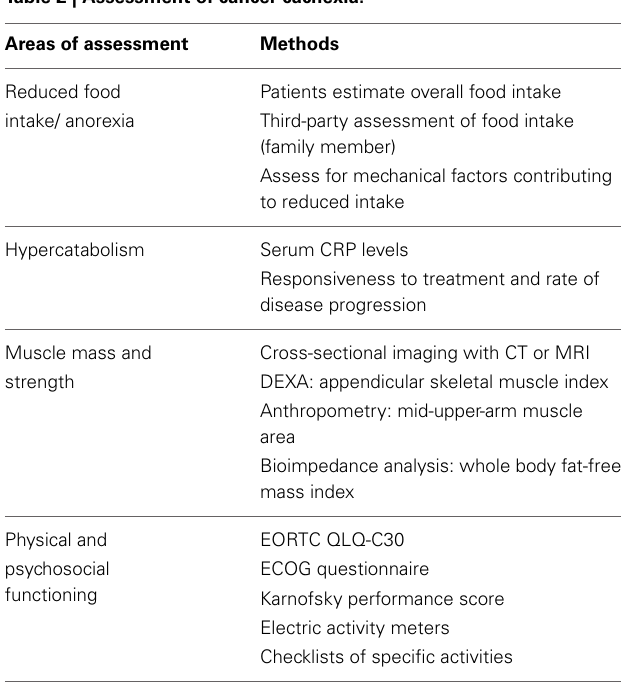
Table 1 | Diagnosis of cancer cachexia (Fearon et al., 2011). Weight loss greater than 5% over the past 6 months; or Weight loss greater than 2% in individuals with BMI less than 20kg/m 2 ; or Evidence of sarcopenia* with weight loss greater than 2% * Sarcopenia defined as appendicular skeletal muscle index in males < 7.26kg/m 2 and in females < 5.45kg/m 2 determined by DEXA.